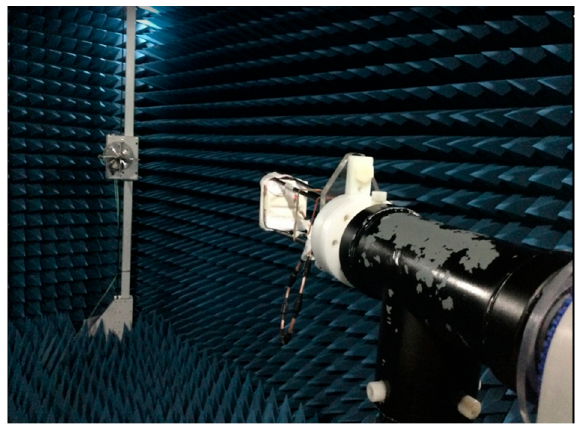
Figure 5. Photographs of the fabricated antenna PCB and the process of measurement.